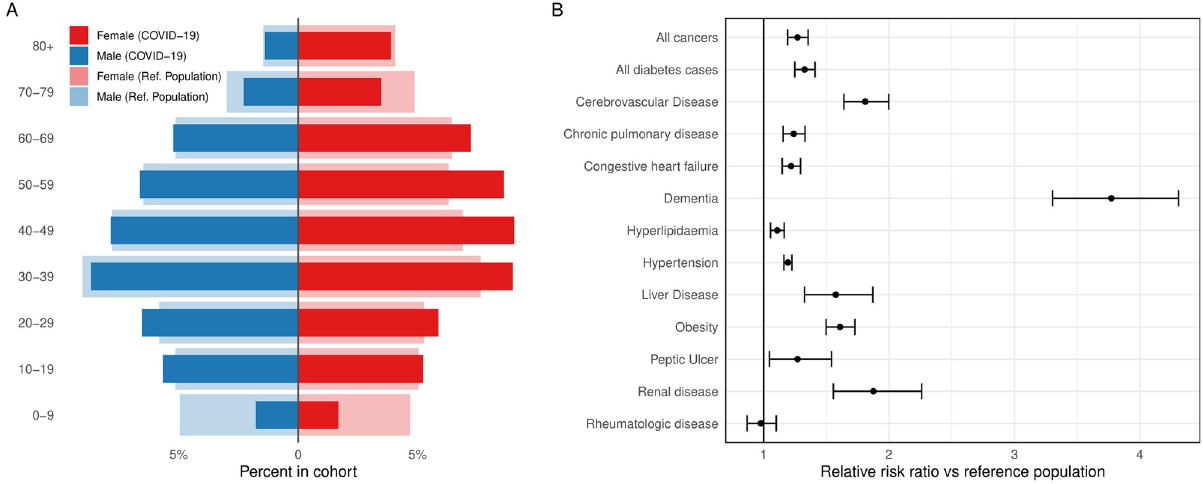
Fig 1. Factors associated with COVID-19 infection. (A) Proportion of patients with positive SARS-CoV-2 PCR test stratified by age and sex compared with the general population. (B) Forest plot showing the association between co-morbid diseases and risk of SARS-CoV-2 infection, adjusted for age and